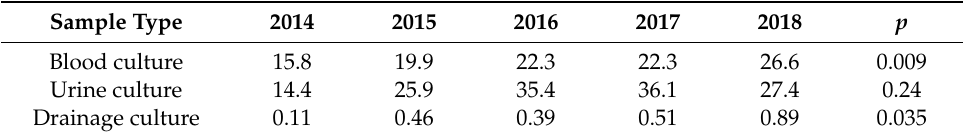
Table 4. Microbiological culture collections (blood culture sets / 1000 patient-days, urine or drainage cultures / 1000